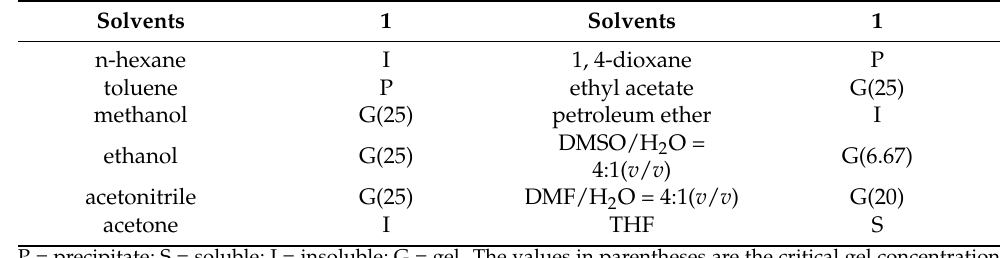
Table 1. Gelation performance of gelator 1 .